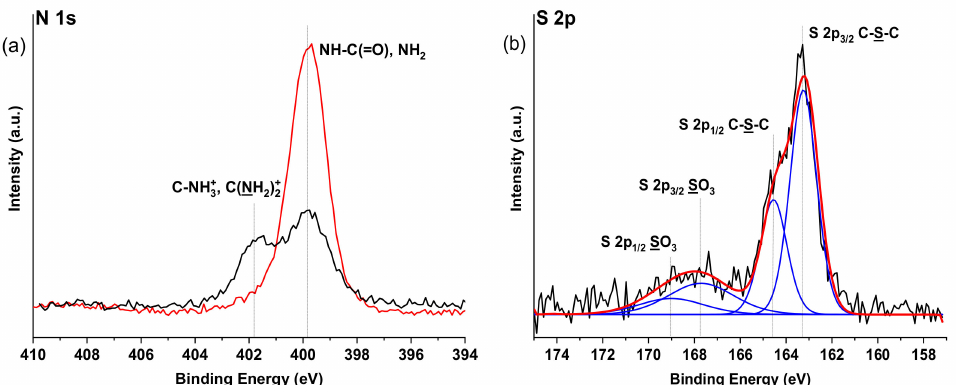
Figure 7. High resolution XPS spectra: ( a ) N1s spectra of Alg-N-AEMI (black) and Alg-N-AEMI-RGD (red); ( b ) high resolution S 2p spectrum shows the successful conjugation of the cysteine group of the peptide to the maleimide group of alginate via the presence of C-S-C